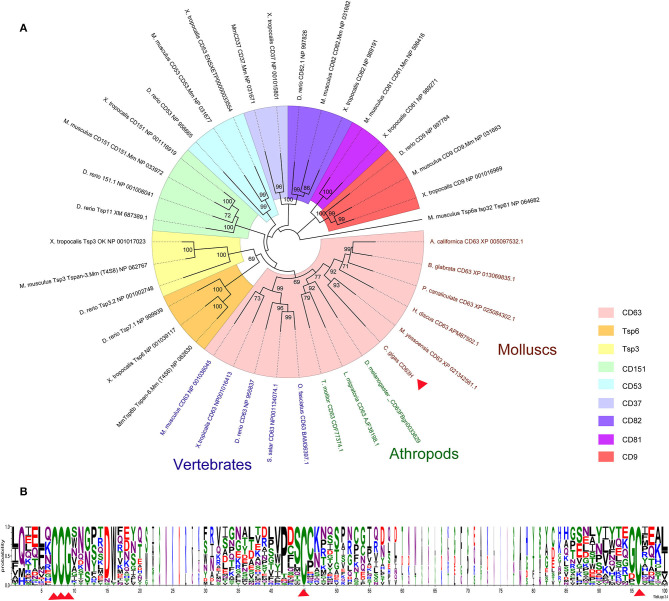
Phylogenetic analysis of CgCD63H. The homologs of CgCD63H from vertebrates (Mus musculus, Xenopus tropicalis, Danio rerio, Salmo salar, and Oplegnathus fasciatus) and invertebrates (Drosophila melanogaster, Tenebrio molitor, Locusta migratoria, Haliotis discus discus, Aplysia californica, Biomphalaria glabrata, Pomacea canaliculata, and Mizuhopecten yessoensis) were retrieved from the National Center for Biotechnology Information (Supplementary Data 1). (A) The unrooted tree was constructed by the neighbor-joining (NJ) algorithm using the Mega 6.06 program based on the multiple sequence alignment by ClustalW. The reliability of the branching was tested by bootstrap (1,000 replicates). Red arrow head indicated CgCD63H. (B) The conserved residues and motifs in large extracellular loop were analyzed based on the multiple sequence alignment.